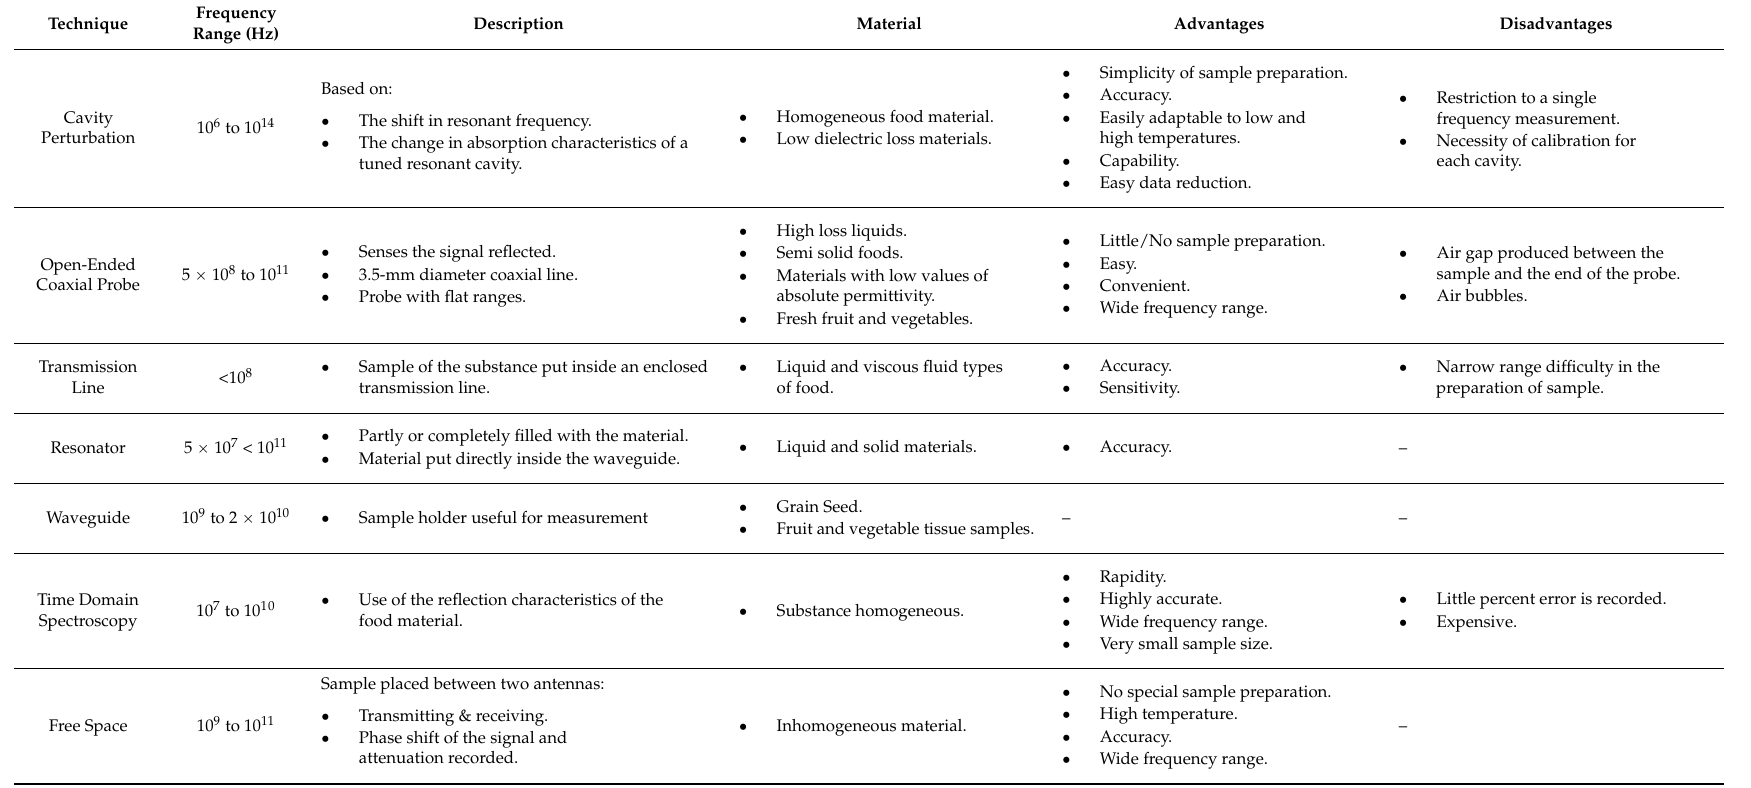
Table 1. Classification of techniques used for the dielectric properties